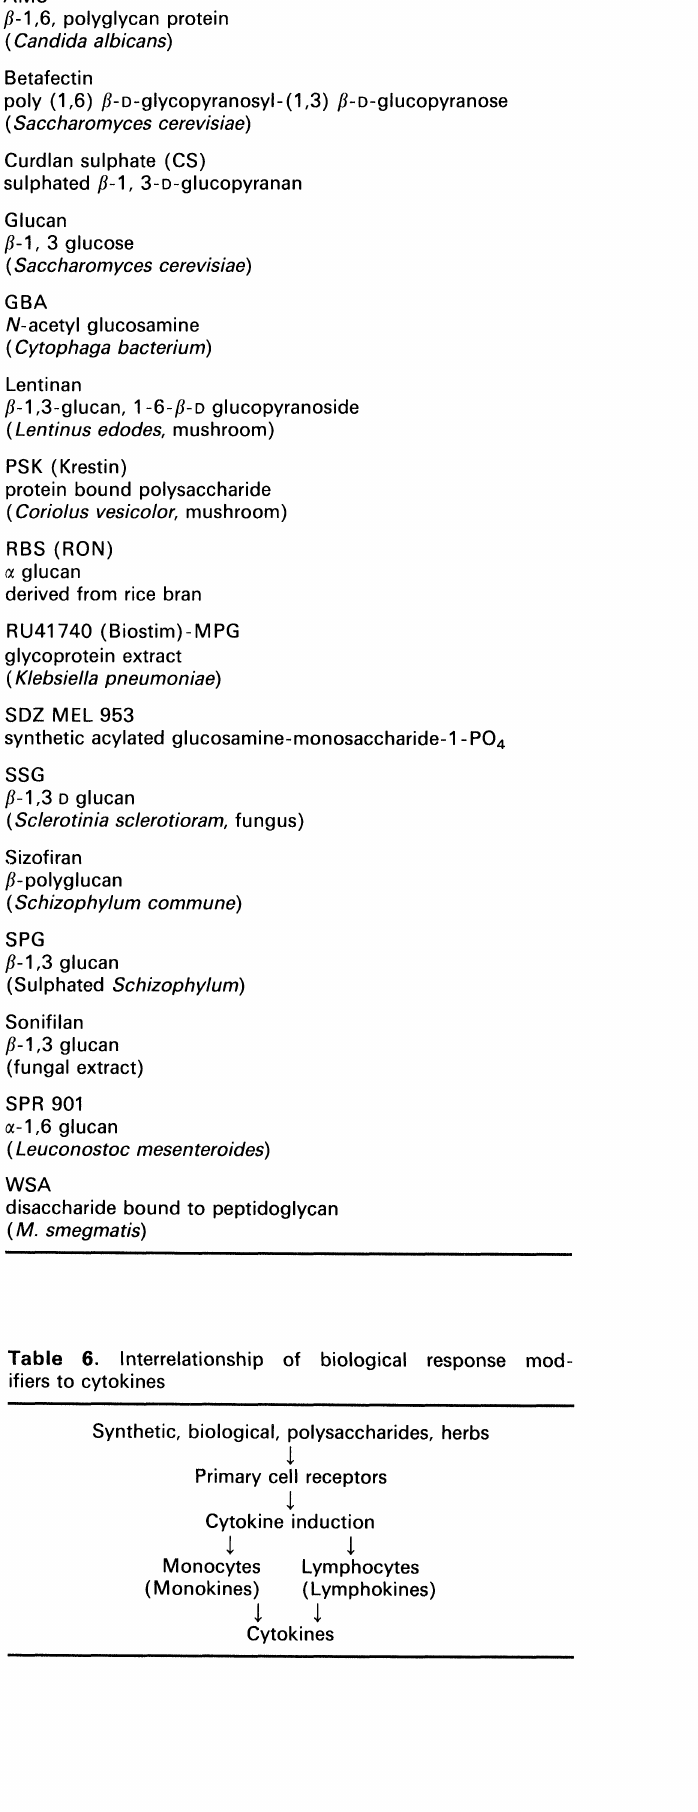
Table 3. Chemically defined biological response modifiers Amphotericin B